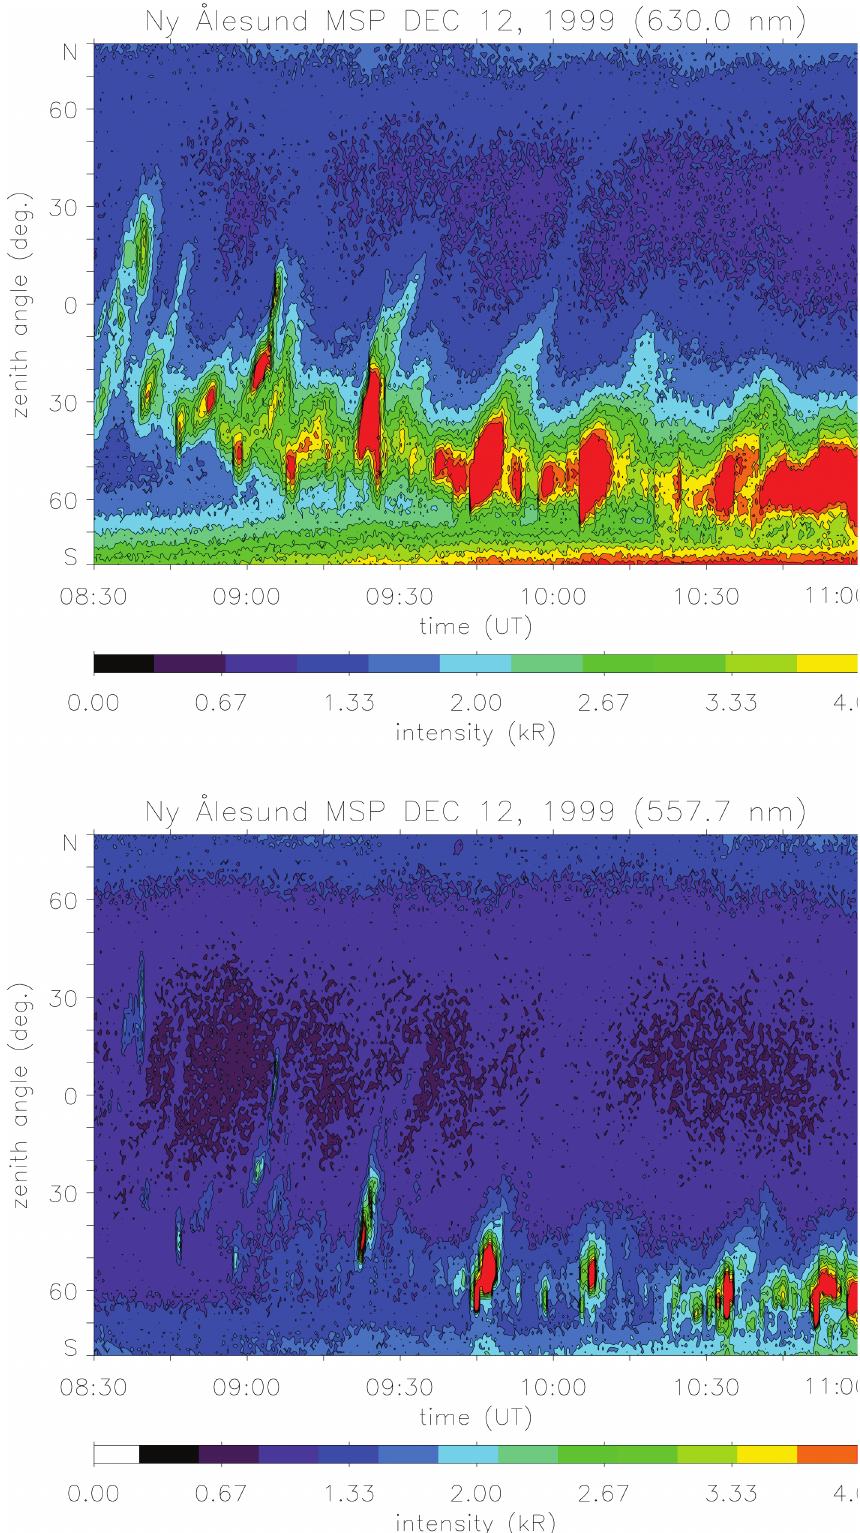
Fig. 15. MSP data from Ny ˚Alesund for the interval 08:30–11:00 UT. The red and green auroral lines at 630.0 and 557.7nm are shown in the upper and lower panels, respectively. Same format as in Fig.